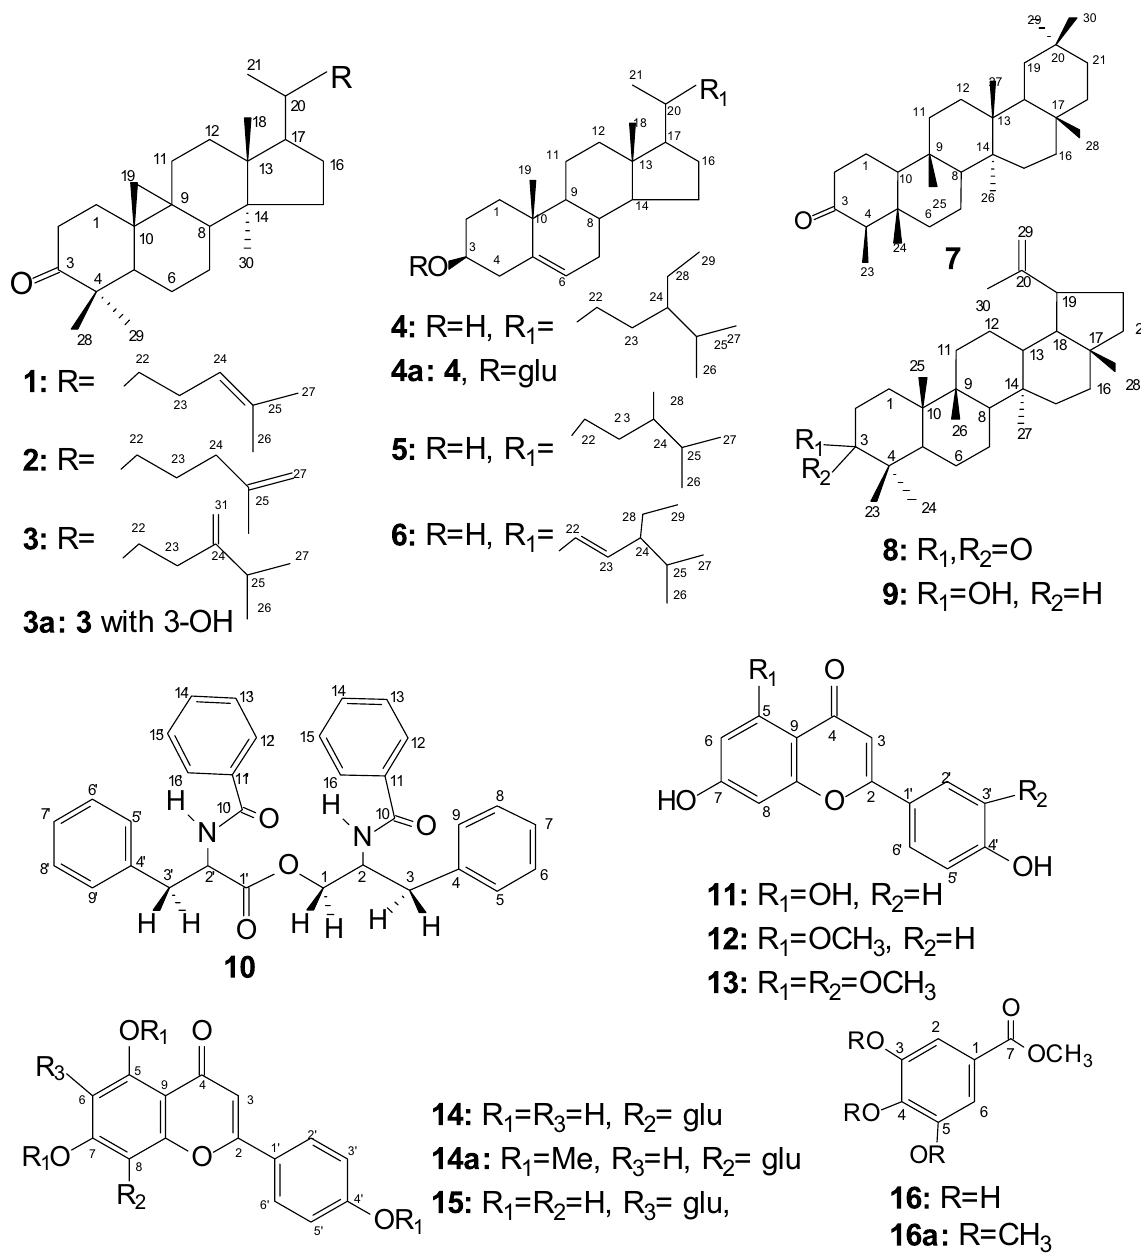
Fig. 2 – Structures of compounds isolated from Piptadenia gonoacantha , “pau